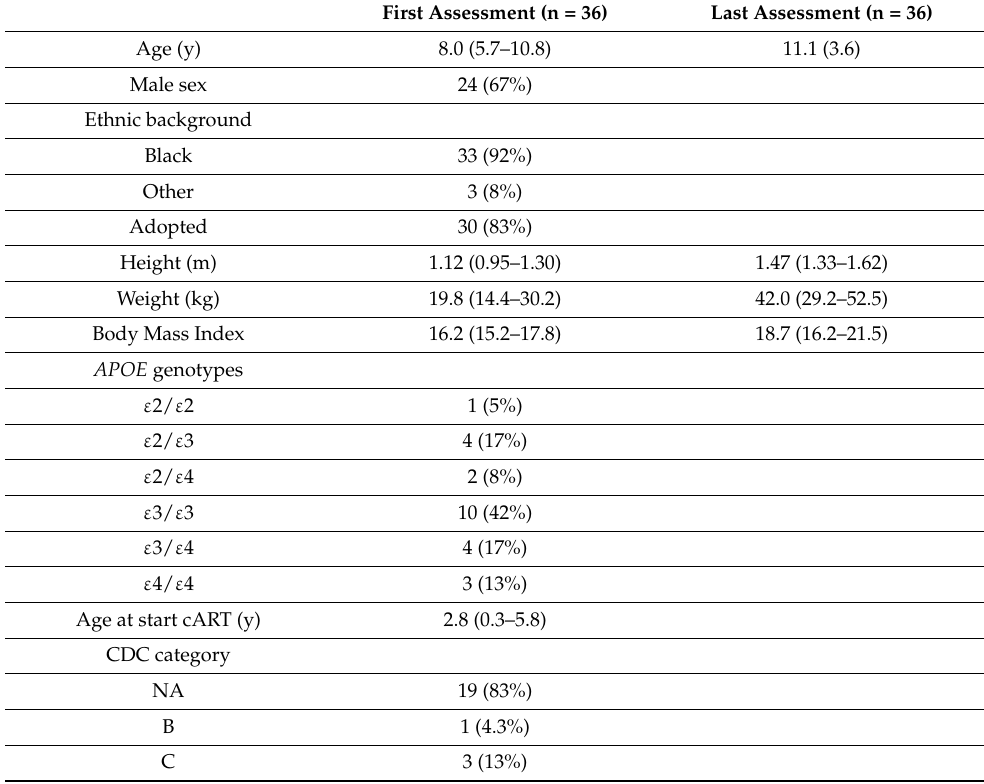
Table 1. Baseline participants’ characteristics of retrospective longitudinal